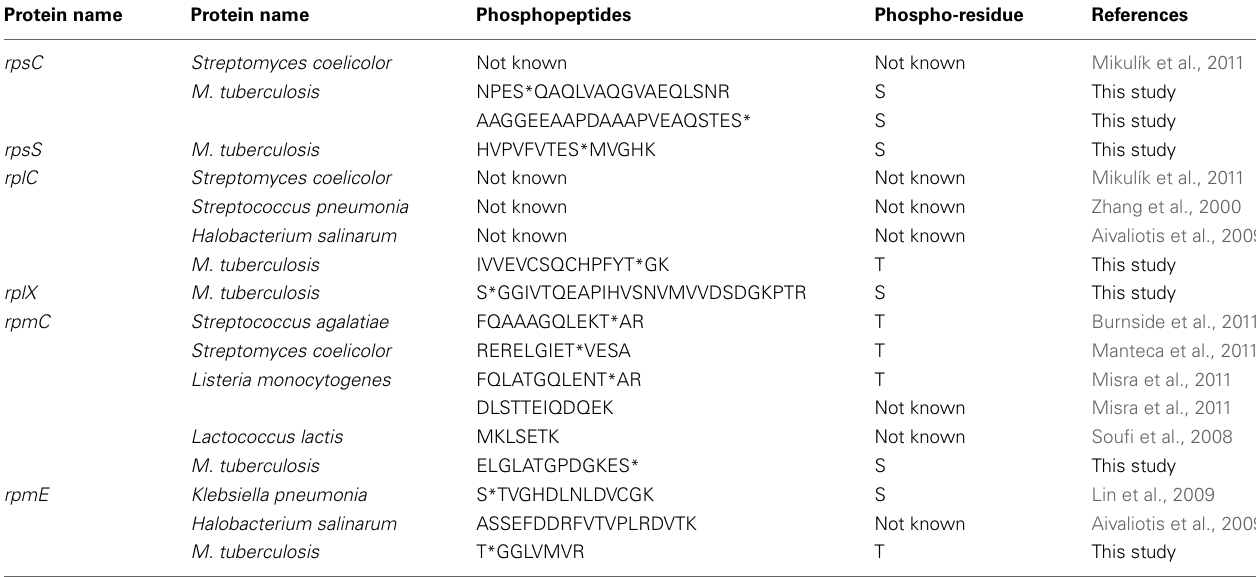
Table 4 | List of phosphorylated ribosomal proteins identified in this study and other